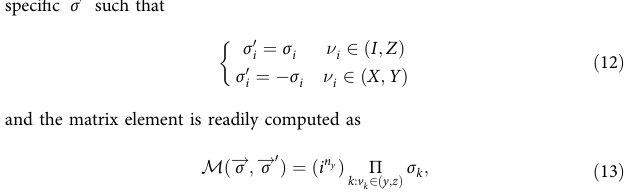
Thebasissetconsidered hereis STO-3G,andthe correspondinggeometries are reportedinthe Methodssection.Energiesare reportedin Hartrees andstatisticaluncertaintyonRBMand Jastrowstates energies are on the last reported digits. The RBM used has a hidden unit density α = 1 for all the molecules apart from C 2 and N 2 where we use α = 2.